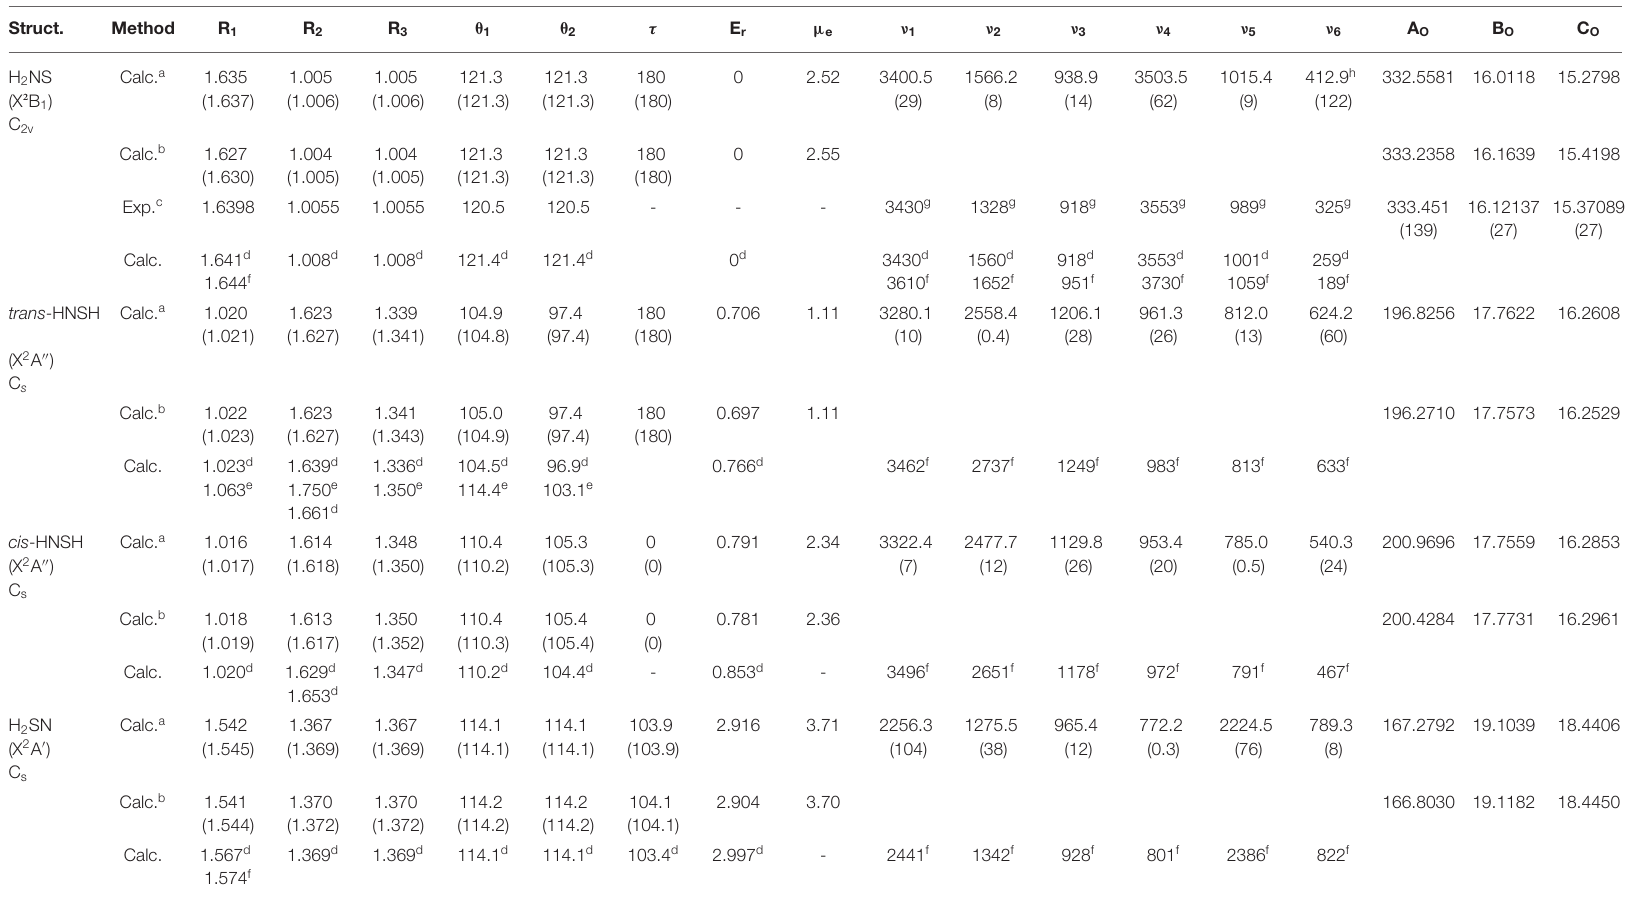
TABLE 2 | Optimized equilibrium geometries and relative energies (E r , eV) of [H,H,N,S] isomers as computed at the RCCSD(T)/CBS and CCSD(T)-F12/CBS levels of theory.